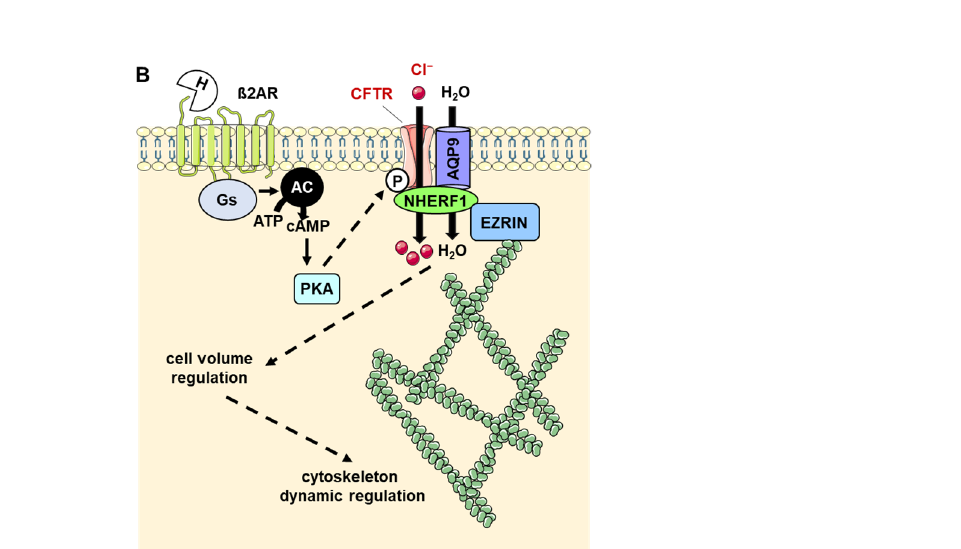
Figure 8. Role of the protein–protein interaction involving AQP9. ( A ) Role in the astrocyte-to-neuron lactate shuttle. Glu enters astrocytes and neurons via GLUT and is transformed into Pyr. In astrocytes, Pyr either used by the mitochondria to produce ATP or is converted to lactate which exits the astrocytes through MCTs 1 and 4. Then, lactate enters neurons via MCT2 and is converted into Pyr, which is used to produce ATP in the mitochondria. Lactate may also directly pass through AQP9. ( B ) Role in vas deferens cells. Upon adrenergic stimulation, ß2AR is activated and leads to subsequent PKA activation, which in turn phosphorylates CFTR. CTRF–AQP9, CTRF–NHERF1 and NHERF1–AQP9 are likely involved in cell volume control. In addition, the NHERF1–Ezrin